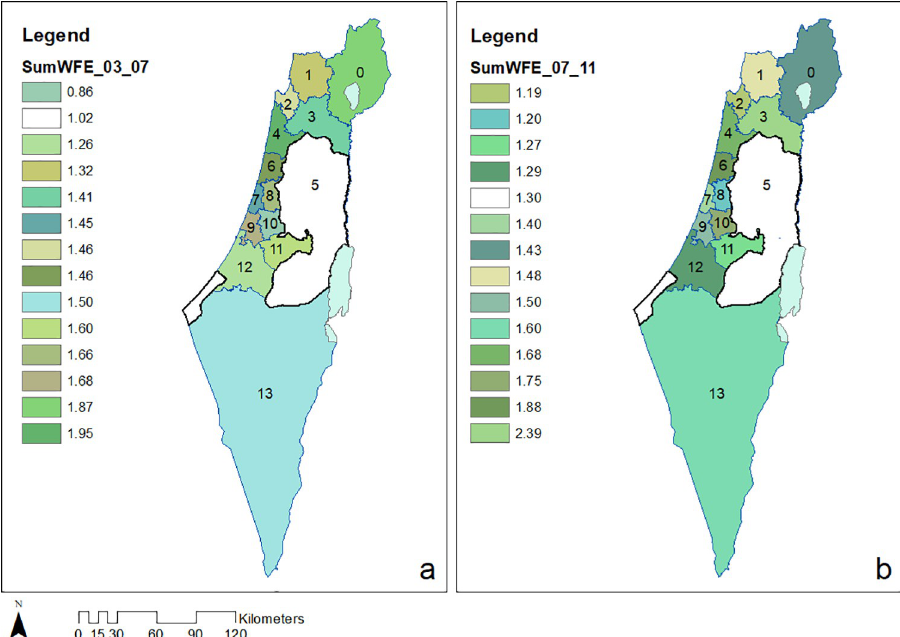
Fig 4. Mean temporal (1), normalized WFE expenditures Volumes per capita over 14 districts for two consecutive periods. (a) 2003–2007 and (b) 2007–2011. Districts enumerations are as in Fig 3. Country borders and district borders have been downloaded from ArcGIS Online [71]. For country borders see: ESRI, Israel Districts Layer– Ministry of Planning, https://www.arcgis.com/home/item.html?id=2749fad1b0bf45e484d5323e296e37cf (06/03/2021). For country districts see: ESRI, Israel Districts Layer–Ministry of Planning, https://www.arcgis.com/home/item.html? id=927cfe72a31e4a05ab130526c1391acf (06/03/2021).